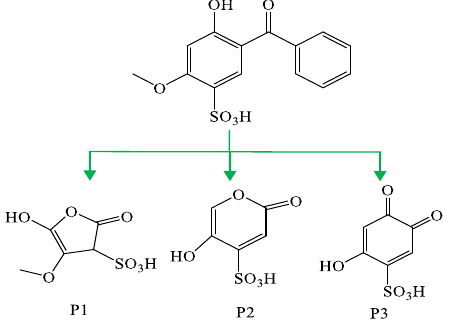
Figure 6. Degradation pathways of BP-4 by ferrate (VI) process.